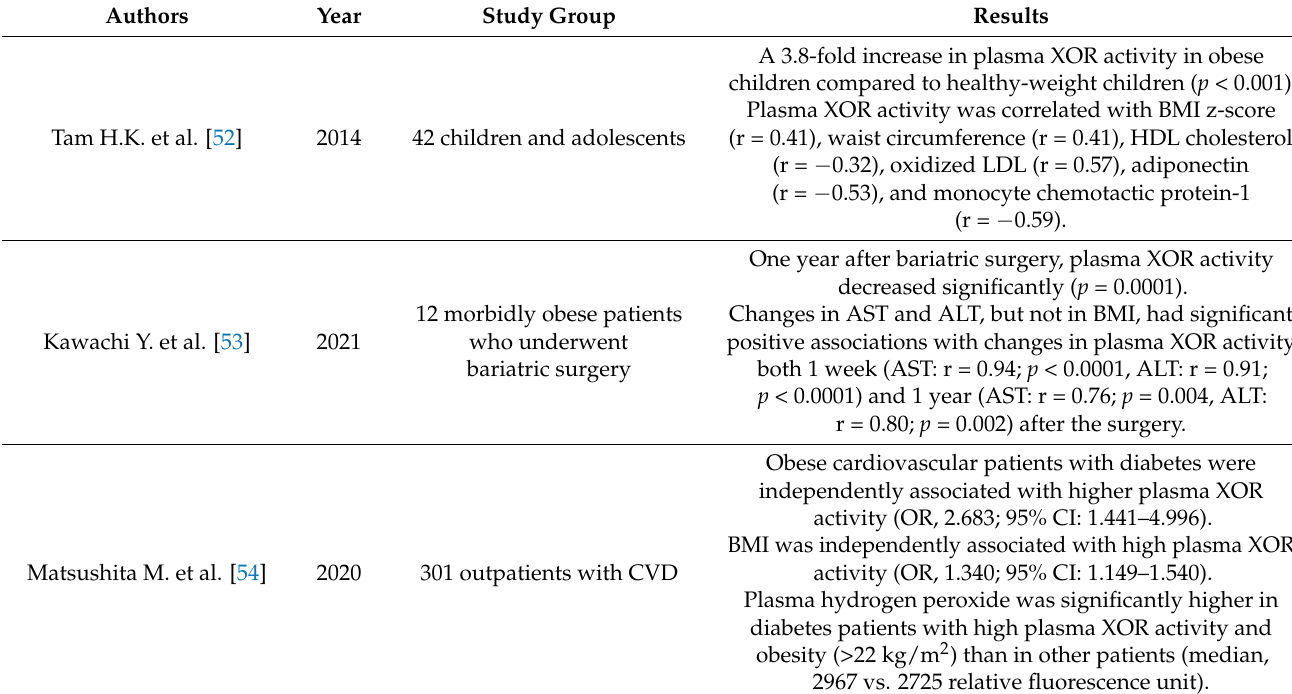
Table 1. Summary of the studies on patients with